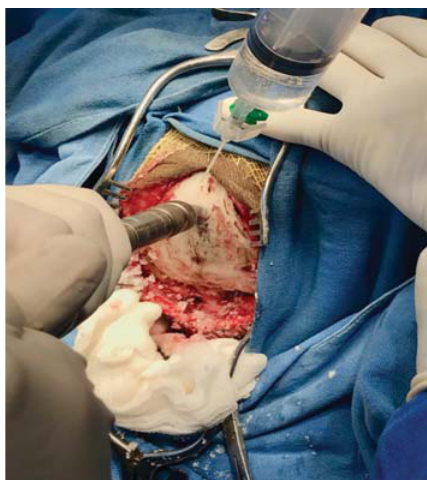
Figure 3. Patient position: Semi sitting and Three Quarter Prone position